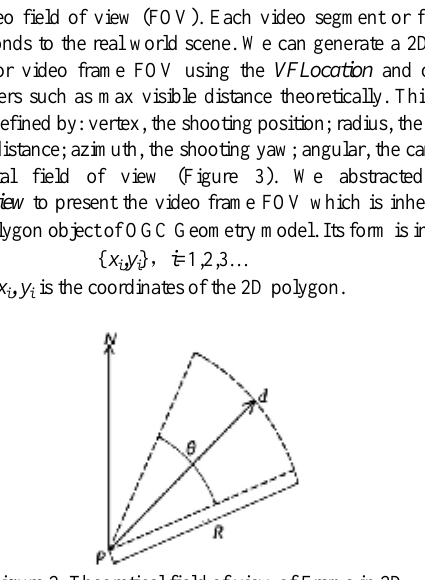
Figure 5. Database representation of